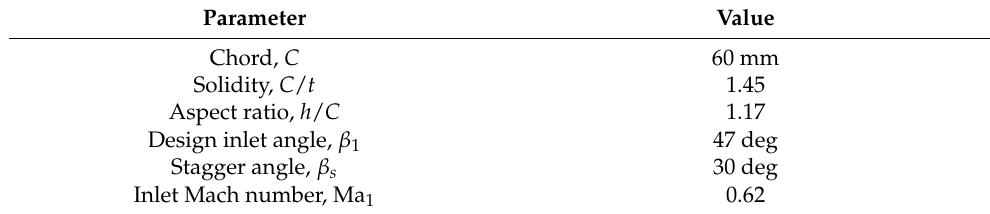
Figure 6. Schematic of the investigated axial compressor cascade.